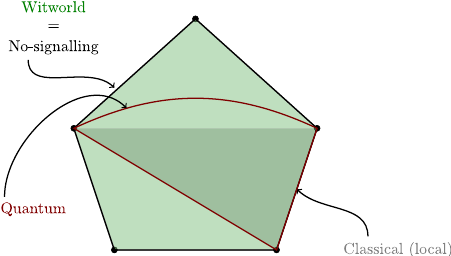
Fig. 2 Pictorial representation of the sets of correlations in Bell scenarios. The polytope of classical (Local Hidden State) correlations is depicted by the grey triangle. The convex set of quantum correlations is depicted by the red-bordered convex region. The set of Witworld correlations is depicted by the green transparent region. The polytope of no-signalling correlations is depicted by the black-bordered pentagon. The sets of no-signalling and Witworld correlations are equivalent. Witworld correlations strictly contain the quantum set, which strictly contains the classical